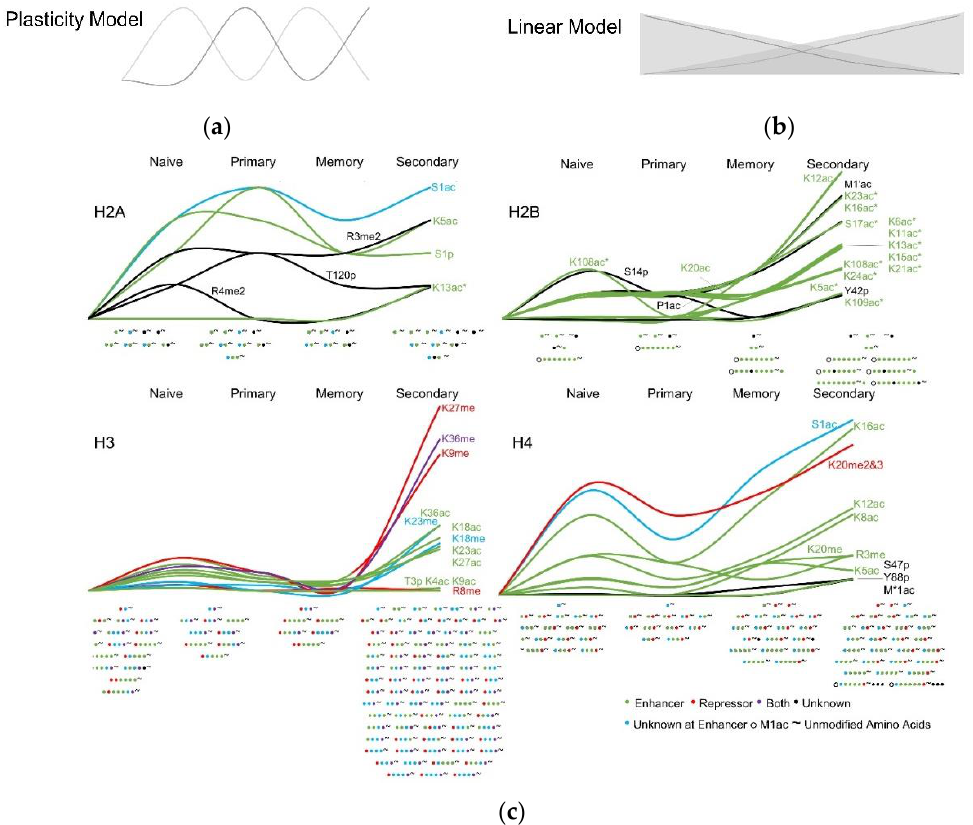
Figure 5. Patterns of histone PTMs over time with CD8 T cell differentiation after influenza infection. T cells have unique histone PTMs that are thought to form based on two models of T cell differentiation. ( a ) In the plasticity model, combinations of PTMs oscillate in on and off patterns as T cells progress through differentiation. In this case, the naïve T cells are activated and differentiate into effector T cells in the primary infection and are either terminally differentiated and contract or form Tm that are activated in the secondary infection and follow the same cycle. In this model, the PTMs cycle in on and o ff and on patterns regulating similar patterns of transcription. ( b ) In the linear di ff erentiation model, T cell progression from naïve to primary or memory is mediated by the persistence and magnitude of antigenic stimulation. E ff ector cells that are not fully di ff erentiated when the activation signal wains remain as memory cells in a transitory state of mixed on or o ff signals that are driven in one direction or the other in the secondary infection. In this model, there is a progressive gain or loss of enhancing and repressing PTMs. ( c ) The presence of individual PTMs in the identified proteoforms was tallied for each T cell subset and graphed. Below the x-axis, each unique combination of PTMs is represented per naïve, primary, memory, and secondary states. PTMs are presented as circles, and the tilde symbol (~) indicates unmodified stretches of amino acids. Circles to the left of the tilde are in the amino-terminal histone tails, and on the right are at the carboxy terminus of the